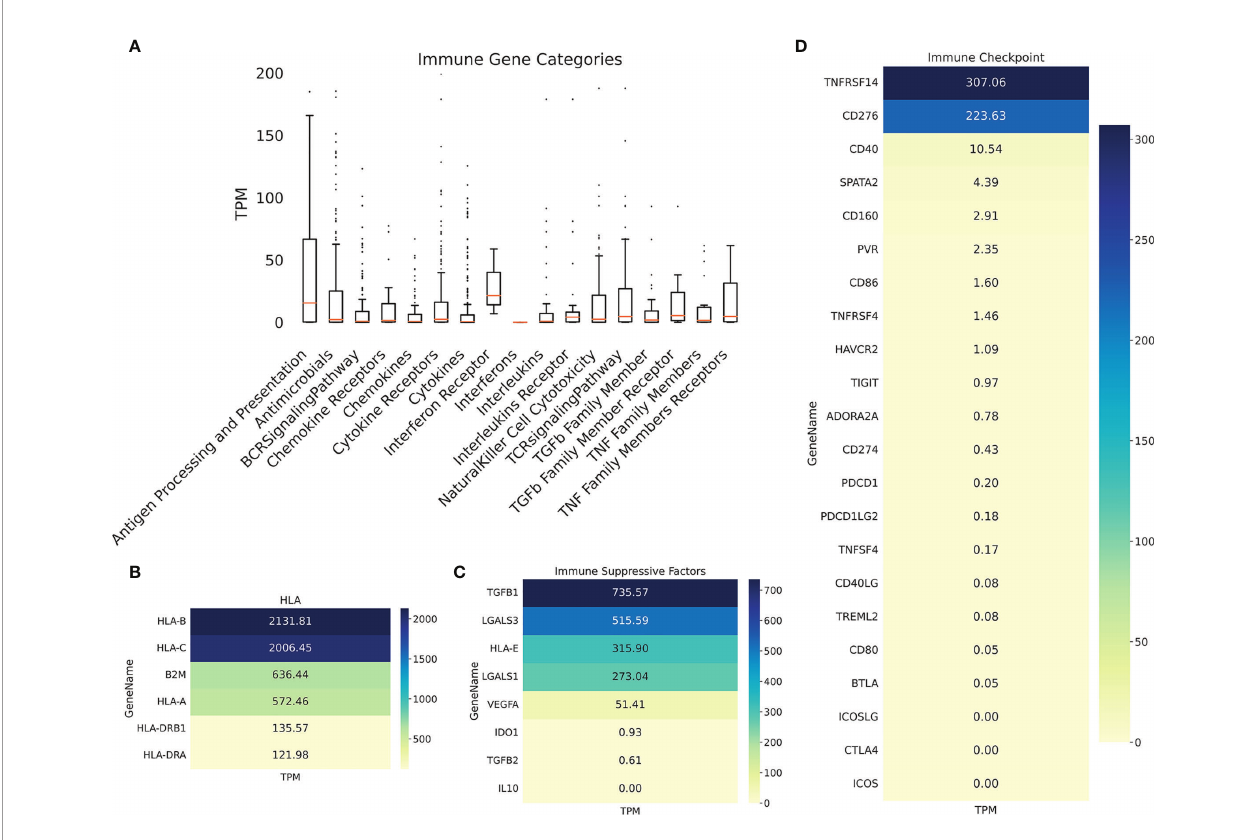
FIGURE 5 | Patient #5 ITM immune genes expression pro fi ling. (A) Boxplot showing expression of immune genes grouped in multiple categories, as described under Methods. Heatmaps showing expression of selected genes: (B) HLA molecules, (C) immunosuppressive molecules; (D) immune checkpoints (receptors and